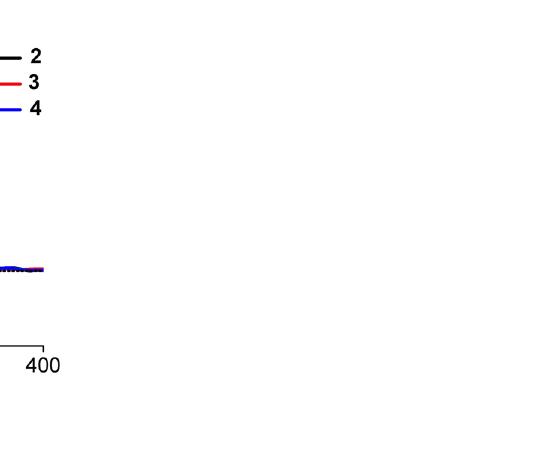
Figure 6. Experimental ECD spectra of 2–4